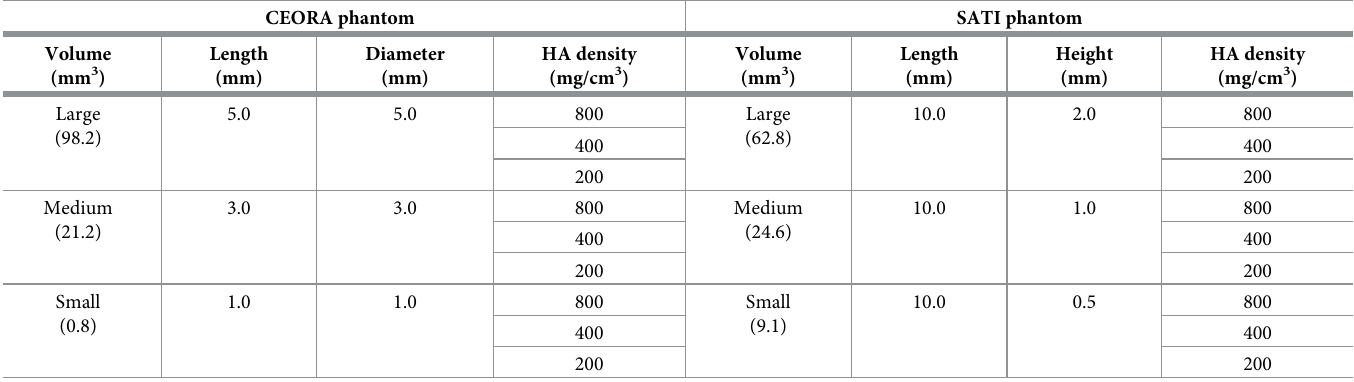
Table 1. Calcification characteristics of the CEORA and SATI